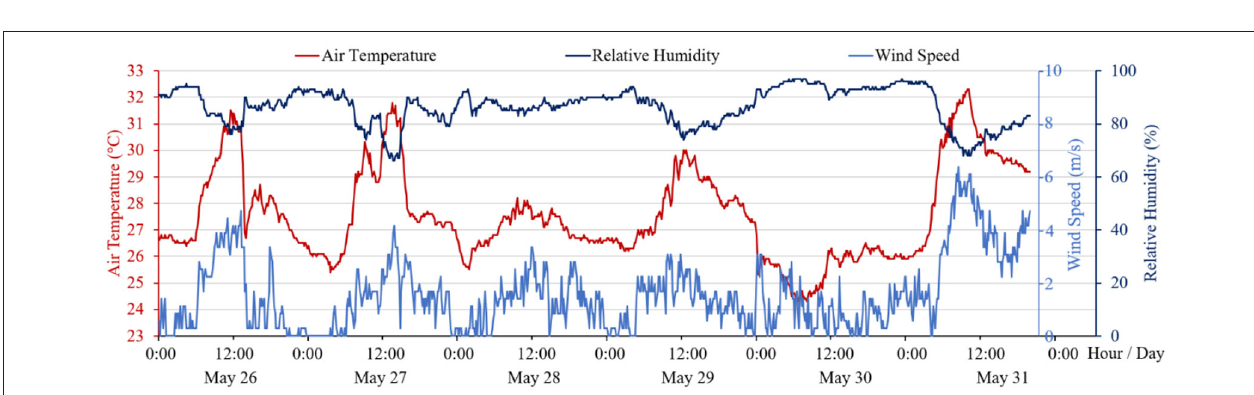
FIGURE 4 | (a) An axiomatic view of the Luk Chuen House in its urban context (Source: Google Map); (b) the floorplan of the Luk Chuen House consisting of an elongated rectangular block with the location of the primary case; and (c) a summary of COVID-19 infection cases marked on a cross section, color-coded by date of symptom onset in Luk Chuen House, Hong